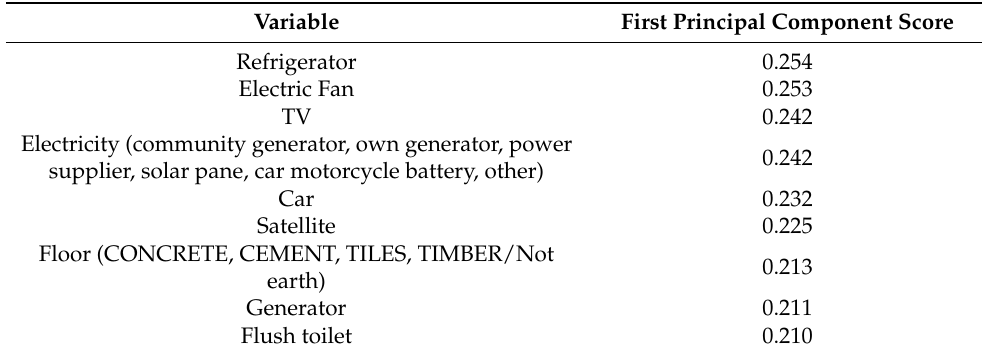
Table A3. Asset index for Liberia—Results from Tetrachoric Principal Components